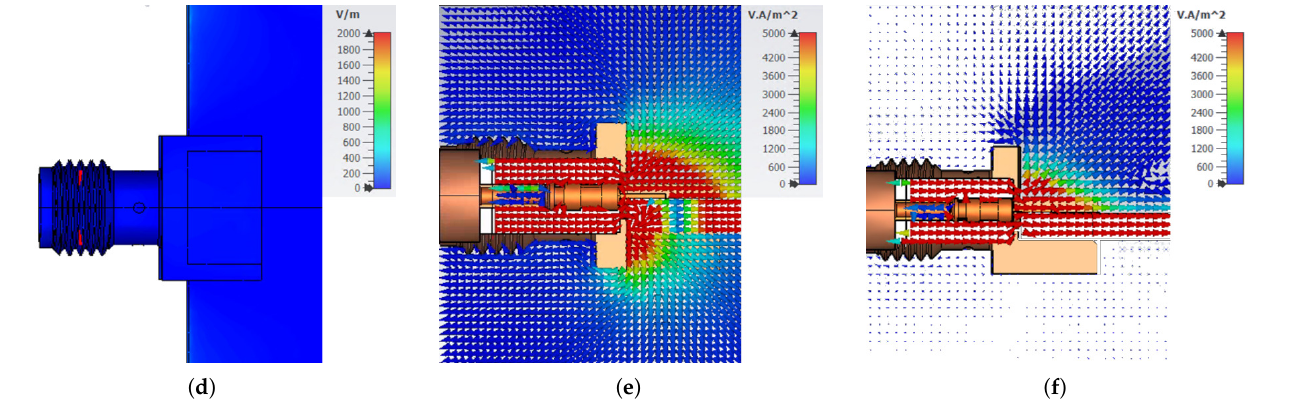
Figure 11. (cid:126) E -field distribution at 15.2 GHz where increased insertion and transmission losses can be observed. ( a , b ) top and bottom view of the (cid:126) E -field resonance occurring at 15.2 GHz. The resonance is caused by the gap between PCB board edge and bottom ground metal. ( c , d ) top and bottom view of the (cid:126) E -field distribution at 15.2 GHz using a solid tin block to connect the bottom ground metal to the SMA connector body. ( e ) side view of the Poynting vector at the SMA-to-PCB interface with a 150 µ m gap between PCB edge and bottom ground metal. ( f ) side view of the Poynting vector at the SMA-to-PCB interface using a solid tin block to overcome the ground